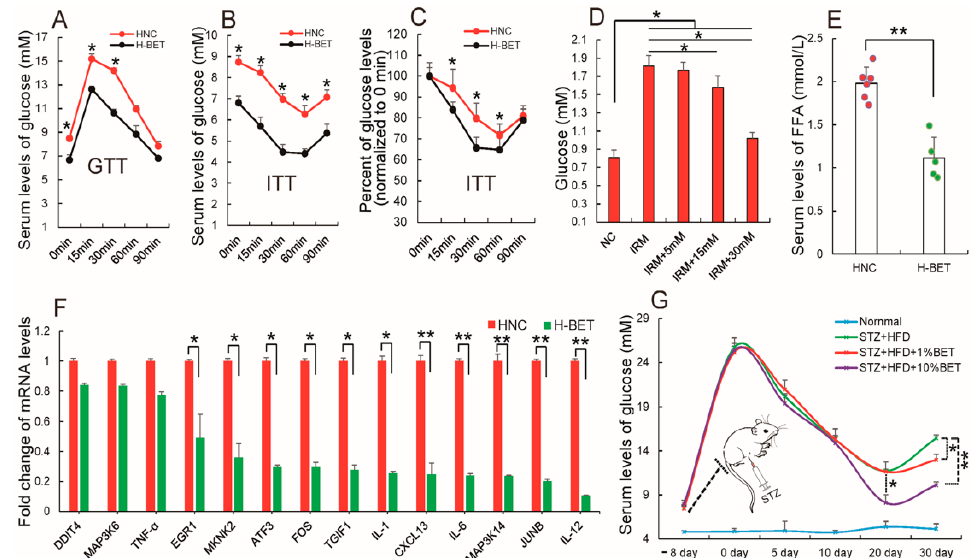
Figure 6. Betaine (BET) supplementation improves insulin resistance. Once mice fed with high-fat diet (HFD) were treated with or without 1% or 10% betaine in water, ( A ) glucose-tolerance tests (GTT) and ( B ) insulin-tolerance tests (ITT) in HFD feeding mice treated with or without betaine were performed; ( C ) Changes of glycemia level on the ITT were indicated as percentage; ( D ) The glucose level of medium cultured insulin-resistant 3T3-L1 cells; ( E ) The serum free fatty acids (FFAs) levels and ( F ) the mRNA levels of some inflammatory stress-related genes in adipose tissues were analyzed; ( G ) Additionally, the serum level of glucose in normal chow (NCW)-fed mice (normal), STZ-injected mice fed HFD which were treated without (streptozotocin (STA) + HFD) and with different does of betaine (STA + HFD + BET) were measured. All results in vivo are presented as means ± standard error (SE). n = 6. * p < 0.05; ** p < 0.01; H-BET, mice fed with HFD and betaine; HNC, mice fed with